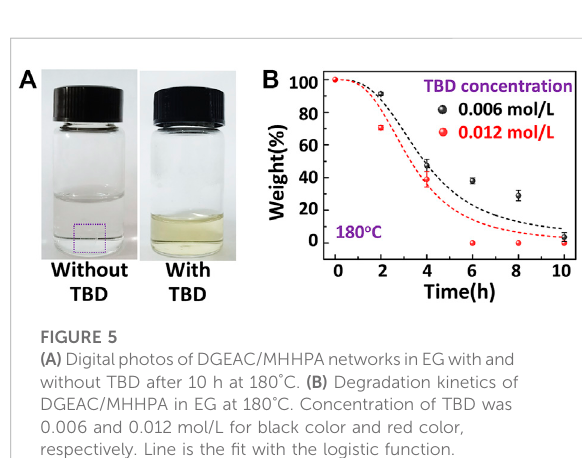
FIGURE 5 (A) DigitalphotosofDGEAC/MHHPAnetworksinEGwithand without TBD after 10 h at 180 ° C. (B) Degradation kinetics of DGEAC/MHHPA in EG at 180 ° C. Concentration of TBD was 0.006 and 0.012 mol/L for black color and red color, respectively. Line is the fi t with the logistic